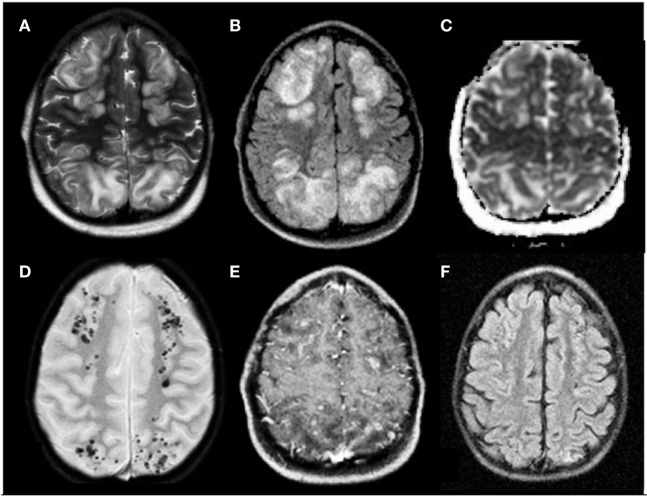
Posterior reversible encephalopathy syndrome in a 5-year-old boy affected by neuroblastoma in treatment with vincristine, etoposide, and carboplatine. (A,B) Axial T2 and FLAIR T2 images, respectively, display iuxtacortical hyperintensities that involve, bilaterally, frontal and parietal parasagittal watershed regions. (C) Diffusion study confirms they represent vasogenic edema. (D,E) Axial T2* and axial T1 post-gadolinium sequences, respectively, reveal microbleeds and faint signs of blood–barrier disruption within the cortex of affected regions. (F) Axial FLAIR T2 image acquired 1 month later shows complete resolution of the vasogenic edema.